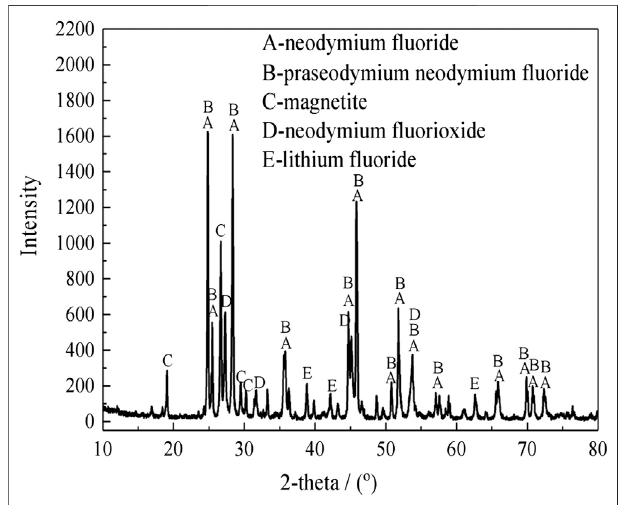
FIGURE 1 | X-ray diffraction pattern of the rare earth molten salt electrolytic